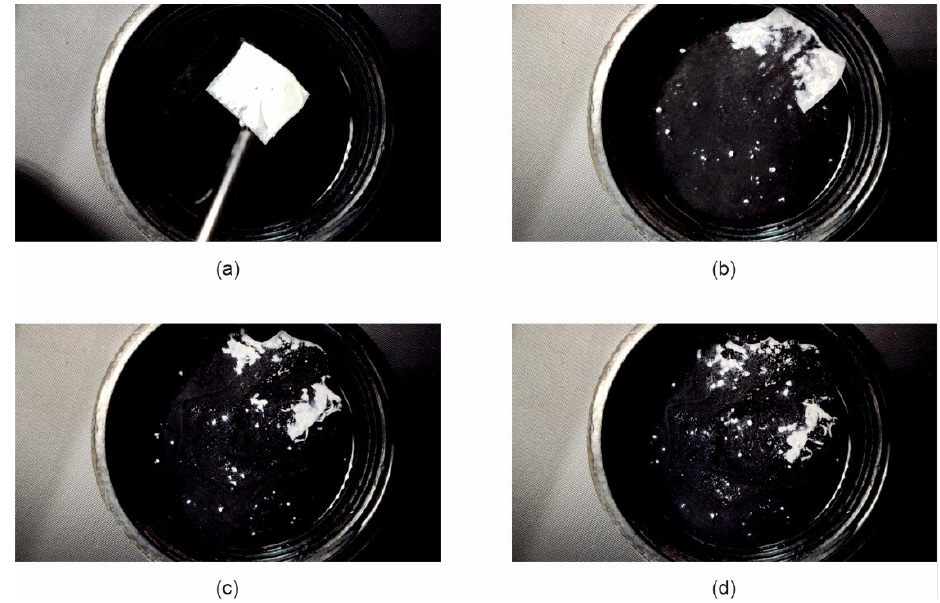
Figure 8. Images of the disintegration of Esp ODF after one month of storage at 25 °C and 60% RH, taken at ( a ) 0 s; ( b ) 1.06 s; ( c ) 4 s; ( d ) 8 s.